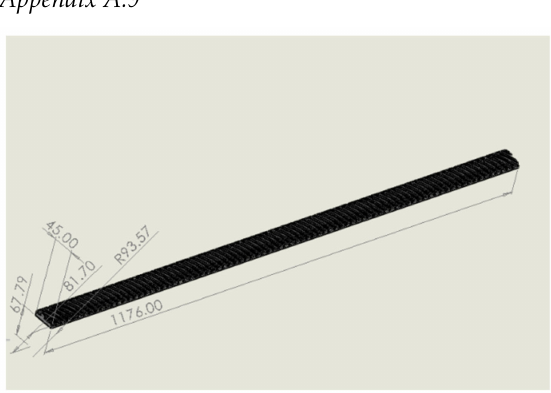
Figure A9. Rasp bar (Dimensions in